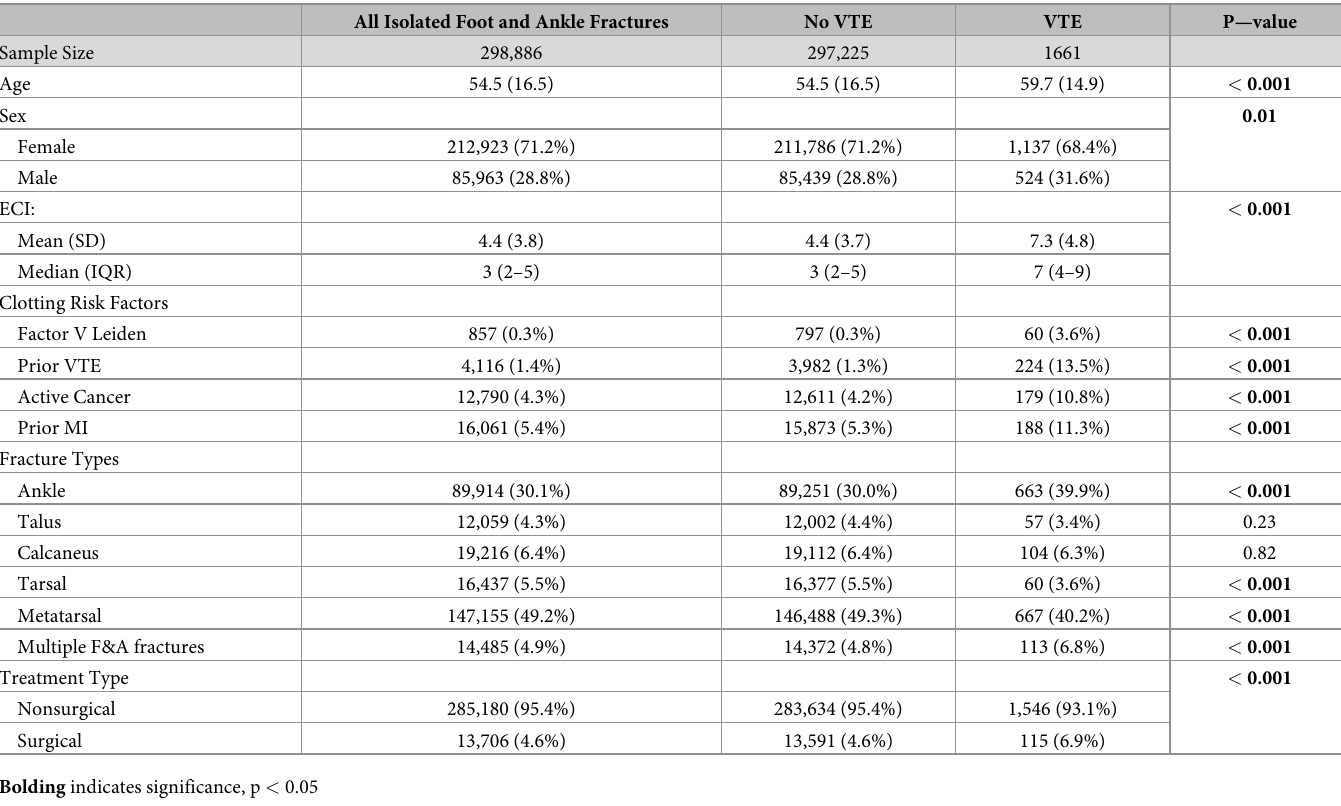
Table 1. Patient characteristics and related variables of those without and with VTE following isolated foot or ankle